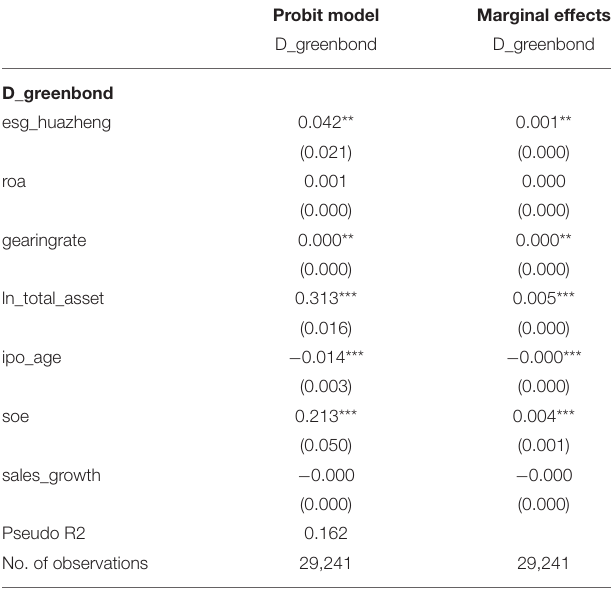
TABLE 4 | The likelihood of green bond issuance within listed companies. Probit model Marginal